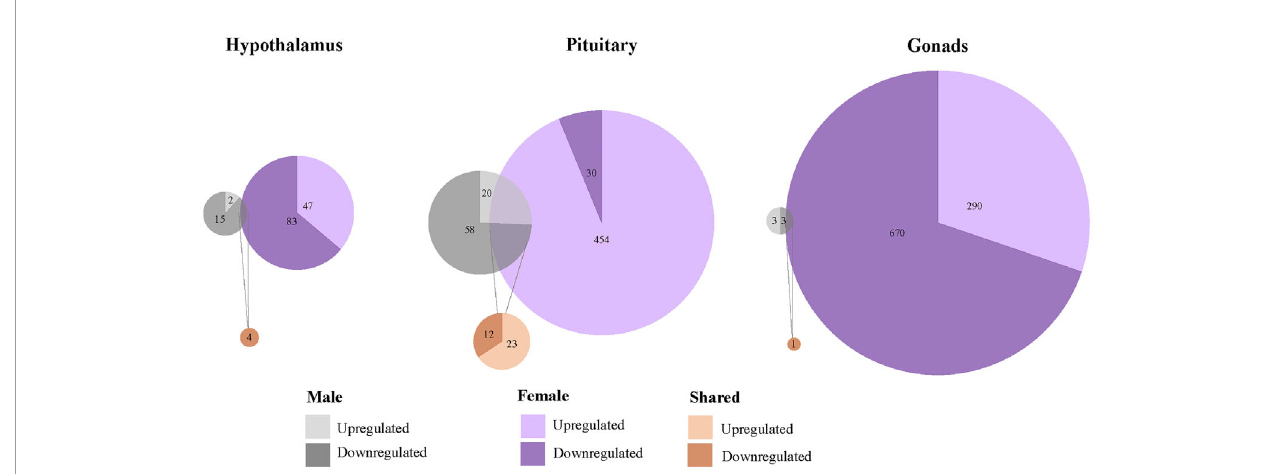
FIGURE 4 | Sex-biased differential genomic expression that uniquely responded to restraint-stress treatment but not CORT treatment. A weighted Venn diagram depicting the overlap of the number of differentially expressed genes between the sexes in the hypothalamus, pituitary, and gonads that uniquely responded to restraint stress and not CORT treatment as compared to controls. Genes that upregulated in expression in response to CORT are depicted by a lighter shade; genes that down-regulated in response are depicted by a dark shade. Numbers within shaded areas indicate the number of restraint stress-responsive